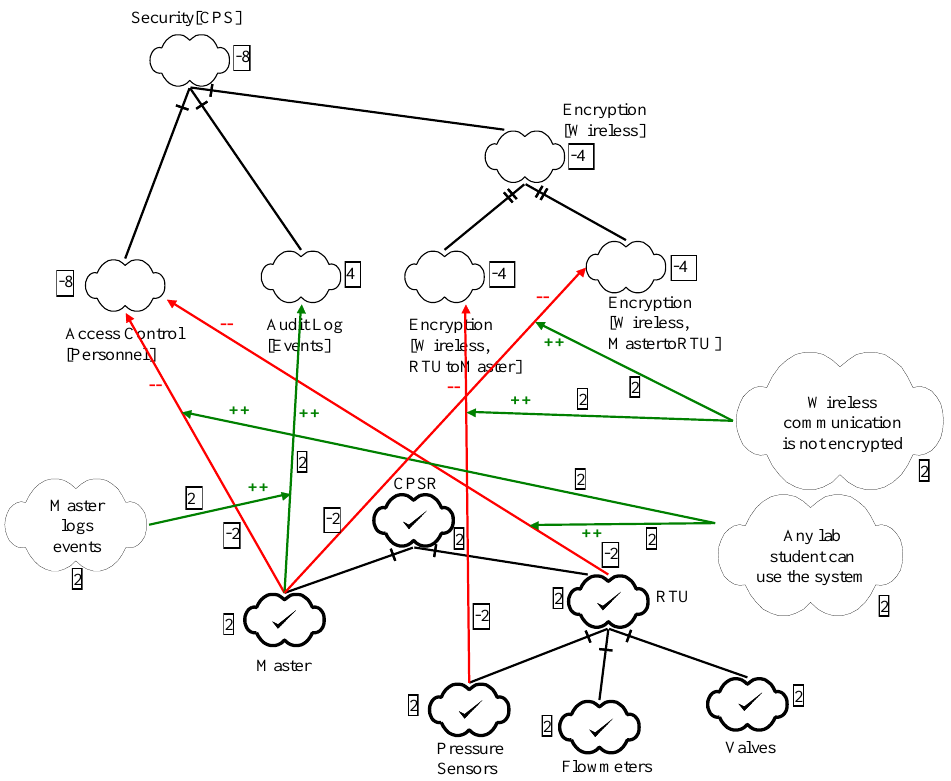
Figure 17. SIG for evaluating security of the cyberphysical system and phase 1 in the NFR approach.